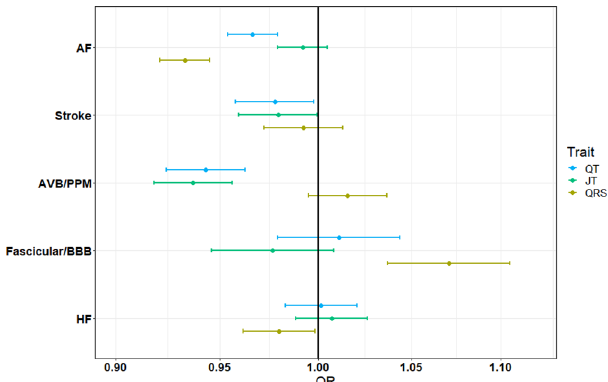
Fig.6|Oddsratiosandcon fi denceintervalsforECGPRSwithclinicaloutcomes in UK Biobank. Data are presented as odds ratios (OR) and 95% con fi dence intervals (lower 2.5% and upper 97.5%) for association of each ECG (QT – blue, JT – green,QRS – yellow)polygenicriskscore(PRS)withprevalentcasesinUKBiobank from logistic regression analyses. Associations are reported as risk per standard deviation increase in the PRS and statistical tests were two sided. To adjust for multiple testing, a Bonferroni-corrected threshold ( P <6.3×10 − 3 ) was used to declare signi fi cance. A total of 371,951 individuals of European ancestry were included in this analysis. AF (Atrial Fibrillation), AVB (Atrioventricular block), PPM (Permanent pacemaker), BBB (Bundle branch block), HF (Heart